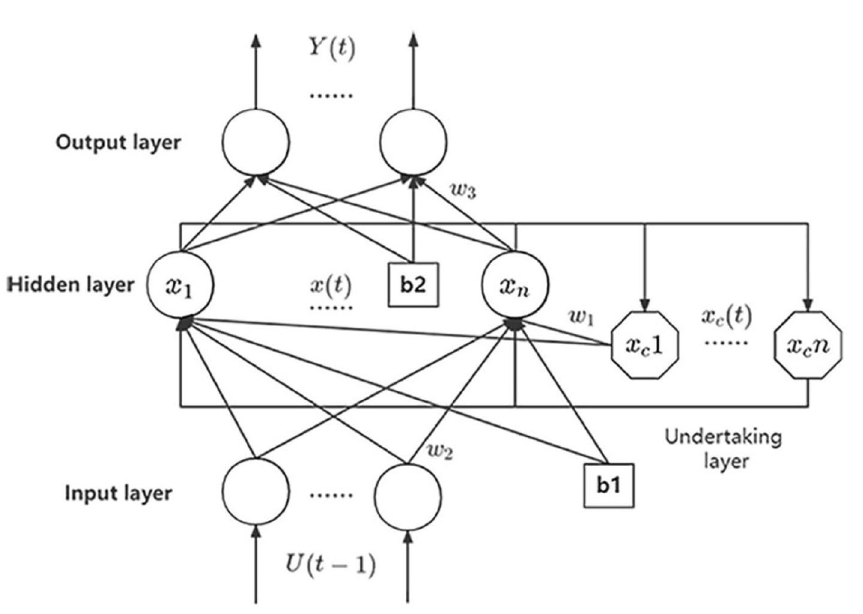
Figure 3. Simple structure diagram of